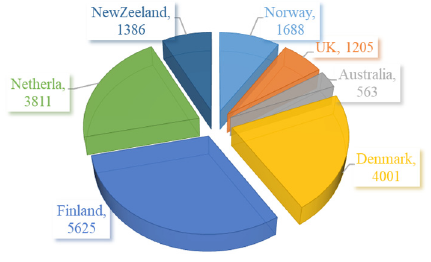
Figure 9. Reduction in CO 2 in tonnes per country and year with ENTEC (adapted with permission from Ref. [34]. Copyright 2021 D í az-Ruiz-Navamuel,